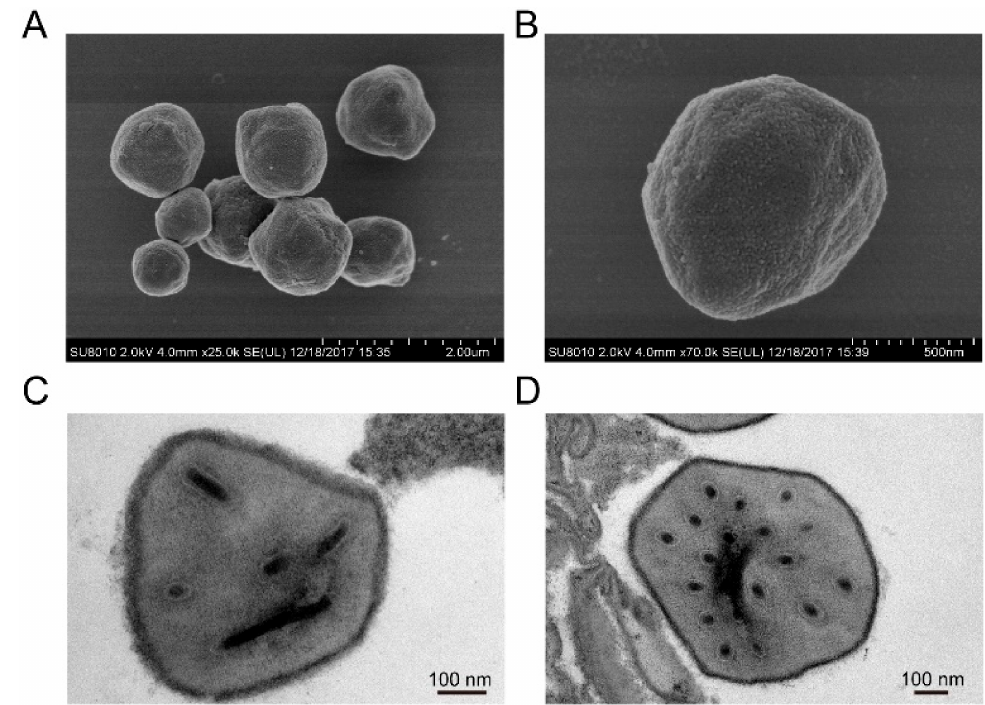
Figure 1. Scanning electron microscopy image of HearNPV-BJ ( A , B ) with the bars representing 200 µ m and 500 nm, respectively, and transmission electron microscopy image of OB of HearNPV-BJ ( C , D ), with both bars representing 100